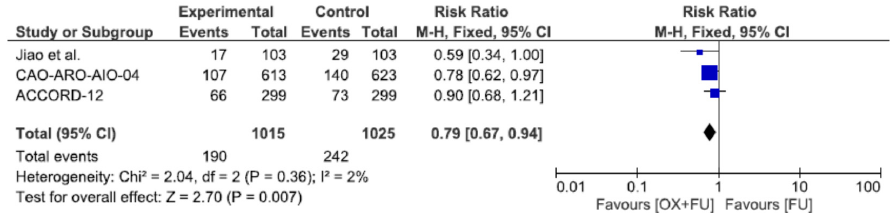
Figure 5. Forest plot of risk ratio for metastatic progression.